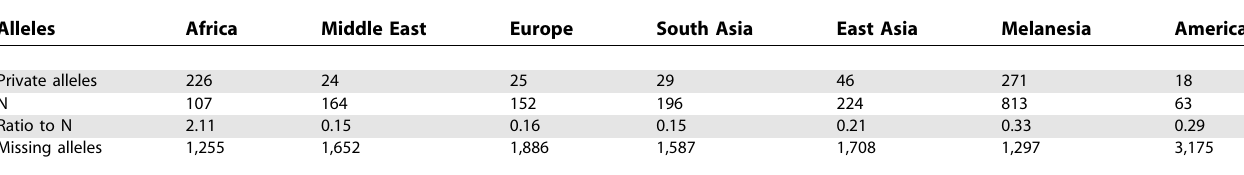
Table 3. Private and Missing Alleles by Continent Alleles Africa Middle